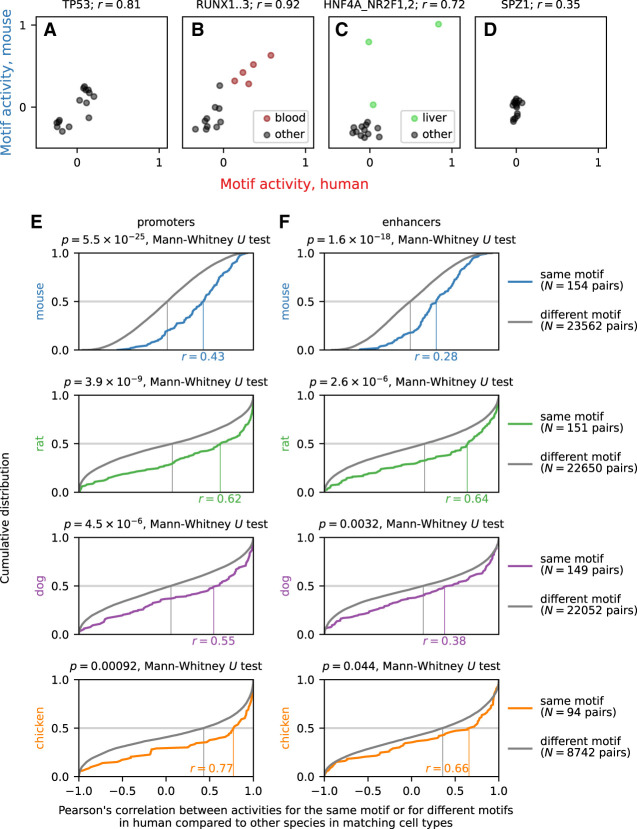
Motif Activity analysis. (A–D) Examples of calculated motif activities in human and mouse for motifs associated with the broadly expressed transcription factor TP53 (A), the hematopoietic lineage-specific RUNX transcription factors (B), the hepatocyte-specific HNF4A transcription factor (C), and the testis-specific transcription factor SPZ1 (D). Each of the 15 matching cell types between human and mouse is shown as a dot. The blood cell types CD19+ B cells, CD4+ T cells, CD8+ T cells, common myeloid progenitors, and granulocyte macrophage progenitors are shown in red for the RUNX motif, and the liver cell types hepatic sinusoidal endothelial cells, hepatic stellate cells (lipocytes), and hepatocytes are shown in green for the motif associated with HNF4A. (E,F) Cumulative distribution of Pearson's correlation r across cell types in motif activity for promoters (E) and enhancers (F) between human and mouse, rat, dog, and chicken. The estimated median value of r is indicated on the horizontal axis of each graph. As a background distribution, we calculated the same correlation between pairs of different motifs in human and mouse, rat, dog, and chicken. The Mann–Whitney U test P-value comparing the actual correlation values to the correlation values of the background distribution is shown for each comparison.